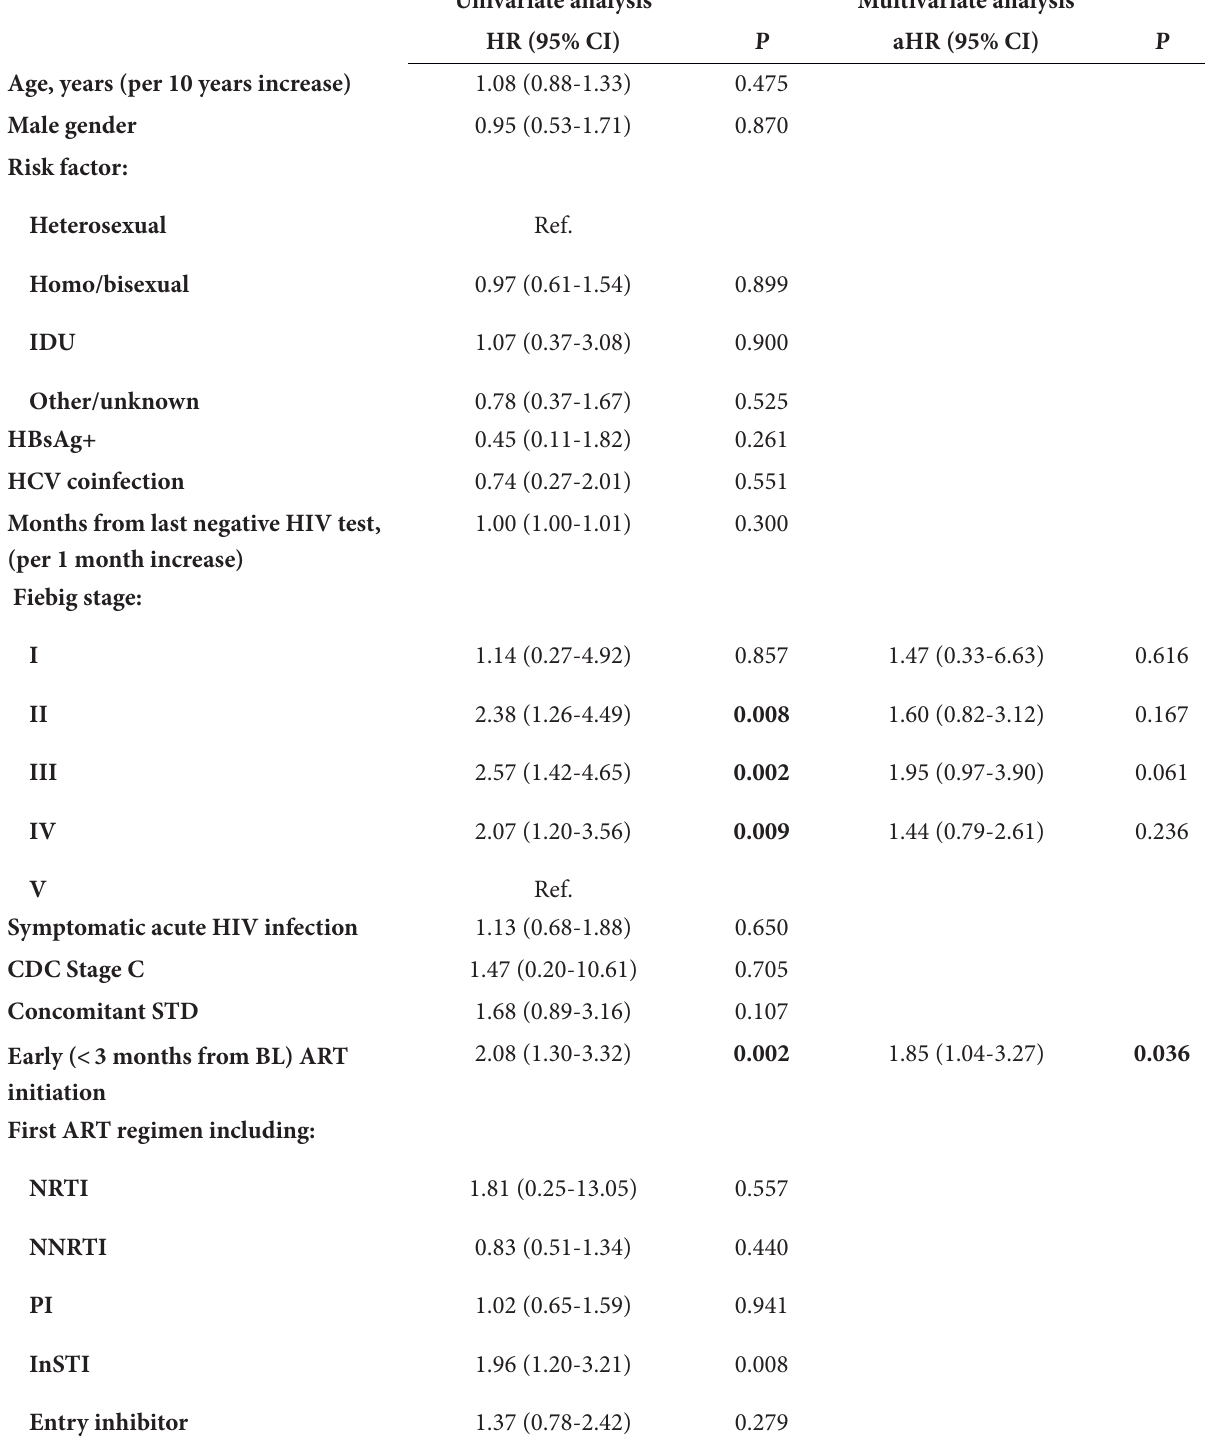
Table 3. Predictors of time to optimal immunological recovery defined as: CD4 ≥